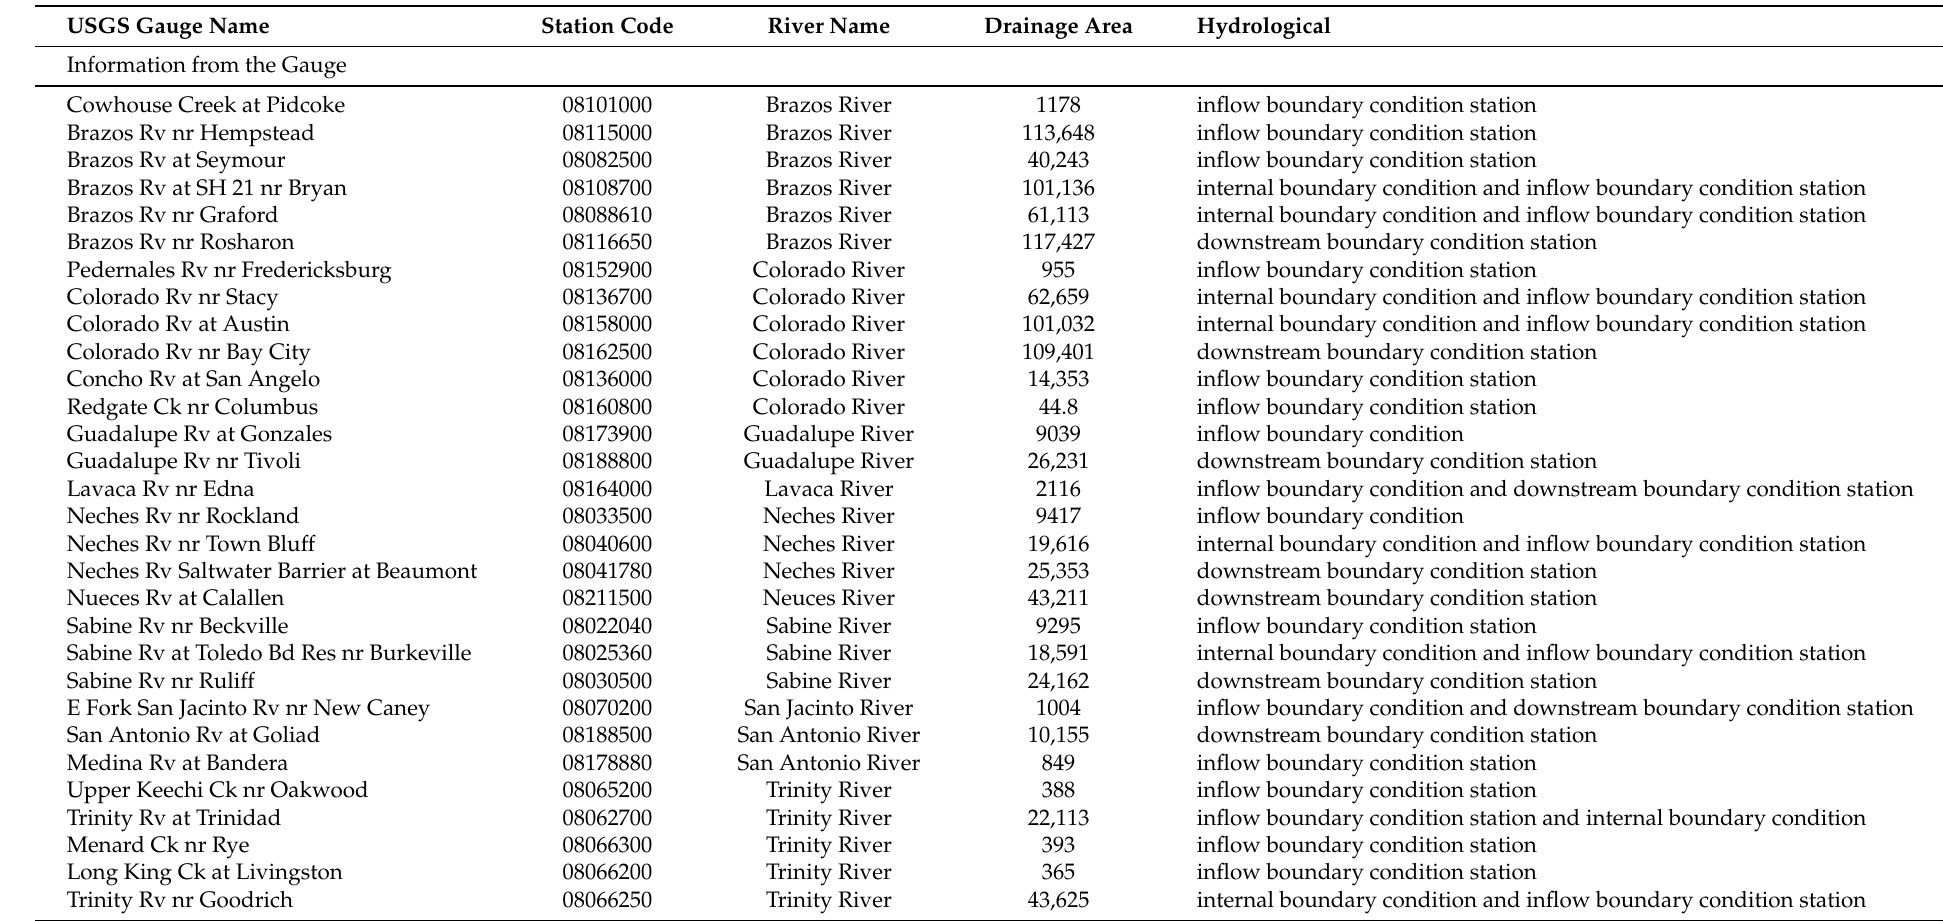
Table A1. Information of selected USGS gauges in Texas–Gulf